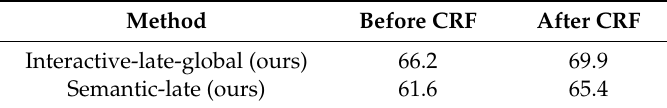
Table 4. Performance of our proposed model with the IU(%) metric before and after CRF. About 4% improvement after